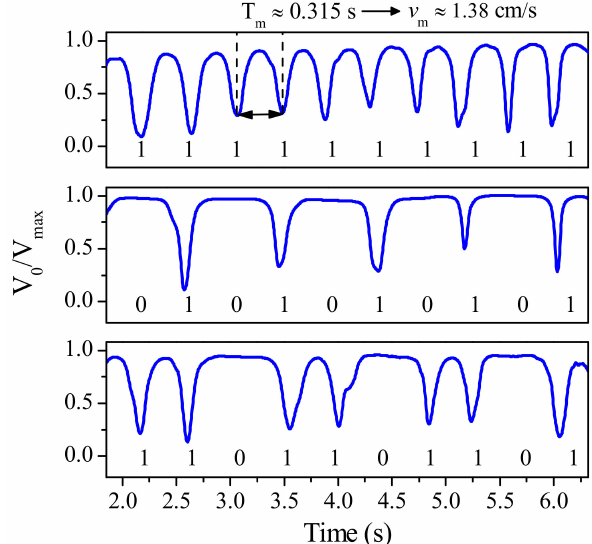
Figure 10. Measured envelope functions for the permittivity contrast electromagnetic encoder of Figure 8. The envelope functions with all the apertures present in the encoder (all bits set to “1”), as well as those envelope functions corresponding to the encoders with the indicated ID codes, are shown. Reprinted with permission from [22]. Copyright 2019